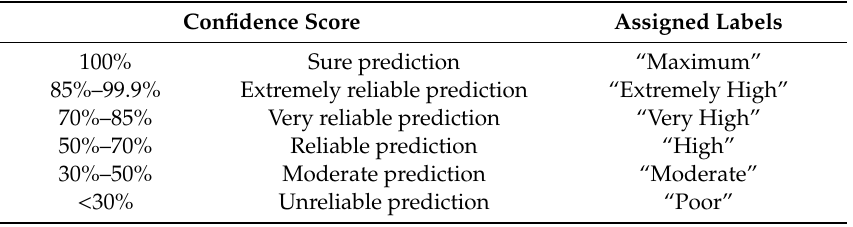
Table 1. Prediction confidence assessment scale and assigned